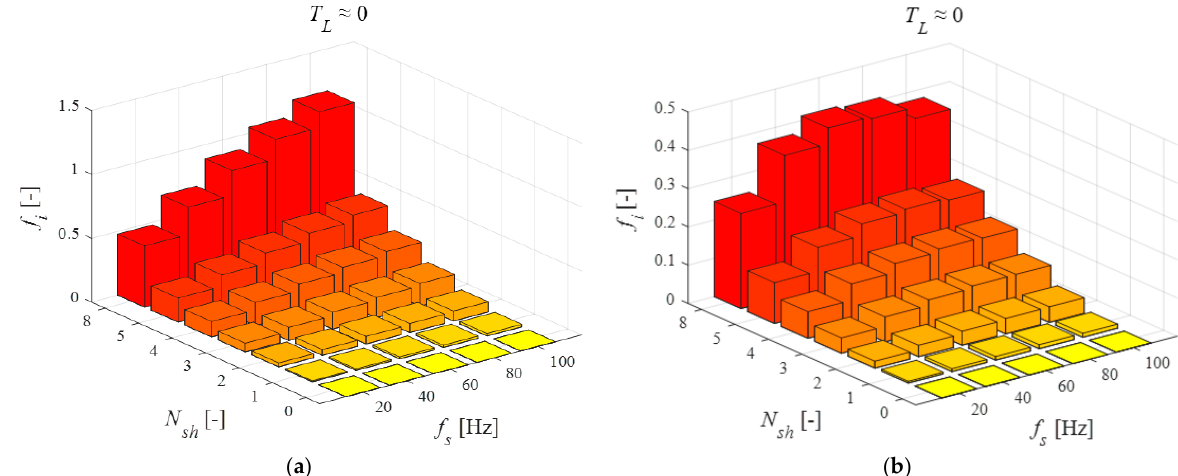
Figure 15. Dependence of the failure index, f i , on the number of shorted turns and the VSI frequency for T L ≈ 0: scalar control ( a ), field-oriented control ( b ). Energies 2021 , 14 , x FOR PEER REVIEW